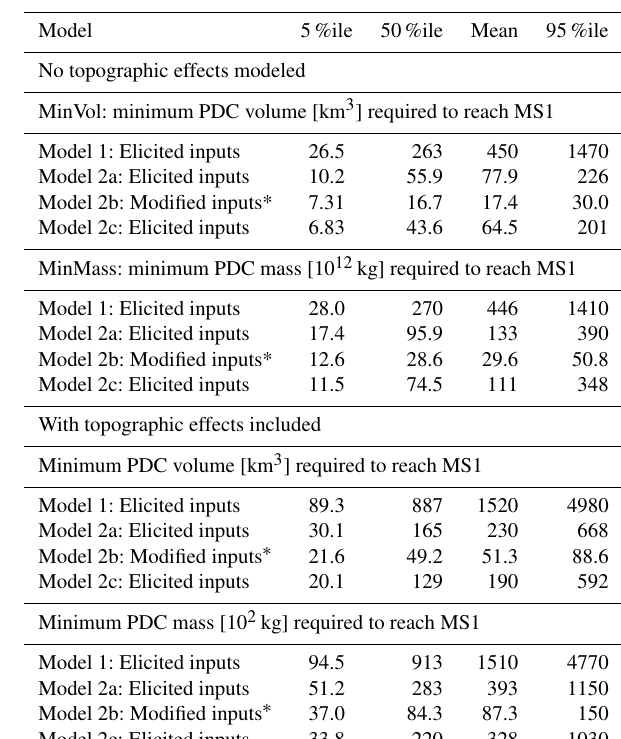
Table 2. Numerical results of the minimum PDC volume and mass needed to reach MS1, with and without consideration of topo- graphic effects (see Sect. 4.4). The density is different in the two models 1 and 2 (see Table 1). Estimates are based on 100000 sta- tistical